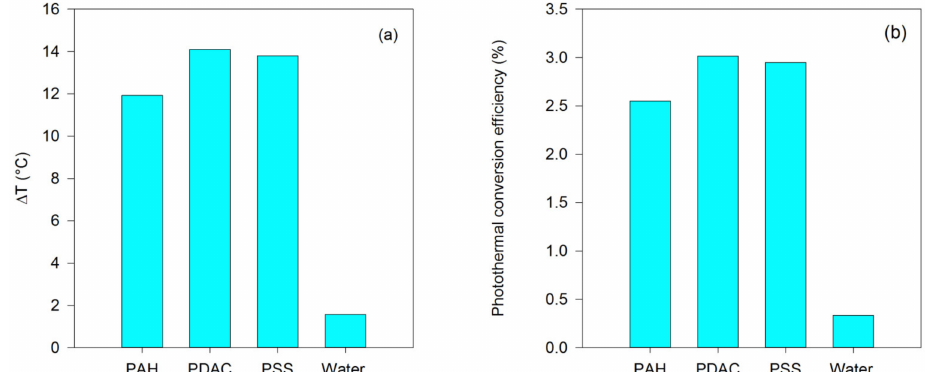
Figure 4. ( a ) Temperature difference and ( b ) photothermal conversion efficiency of PAH-GNRs, PDAC-GNRs, PSS-GNRs, and water (100 µ L) after irradiation with 650 mW of a 653 nm laser for 5 min. The irradiation of water was performed as a control experiment.